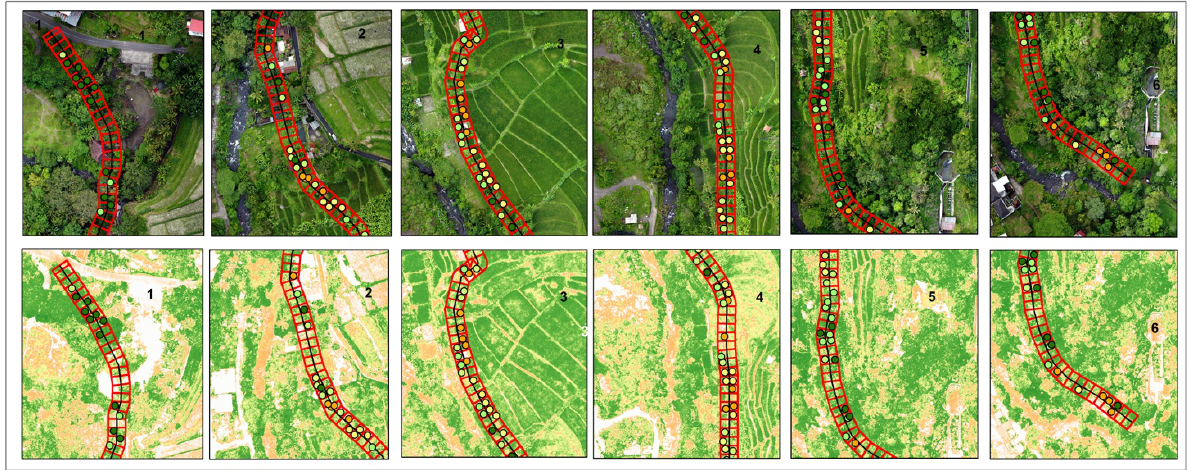
Figure 3 . Comparison of the field observation data points of vegetation density on the UAV imagery and GRVI image result